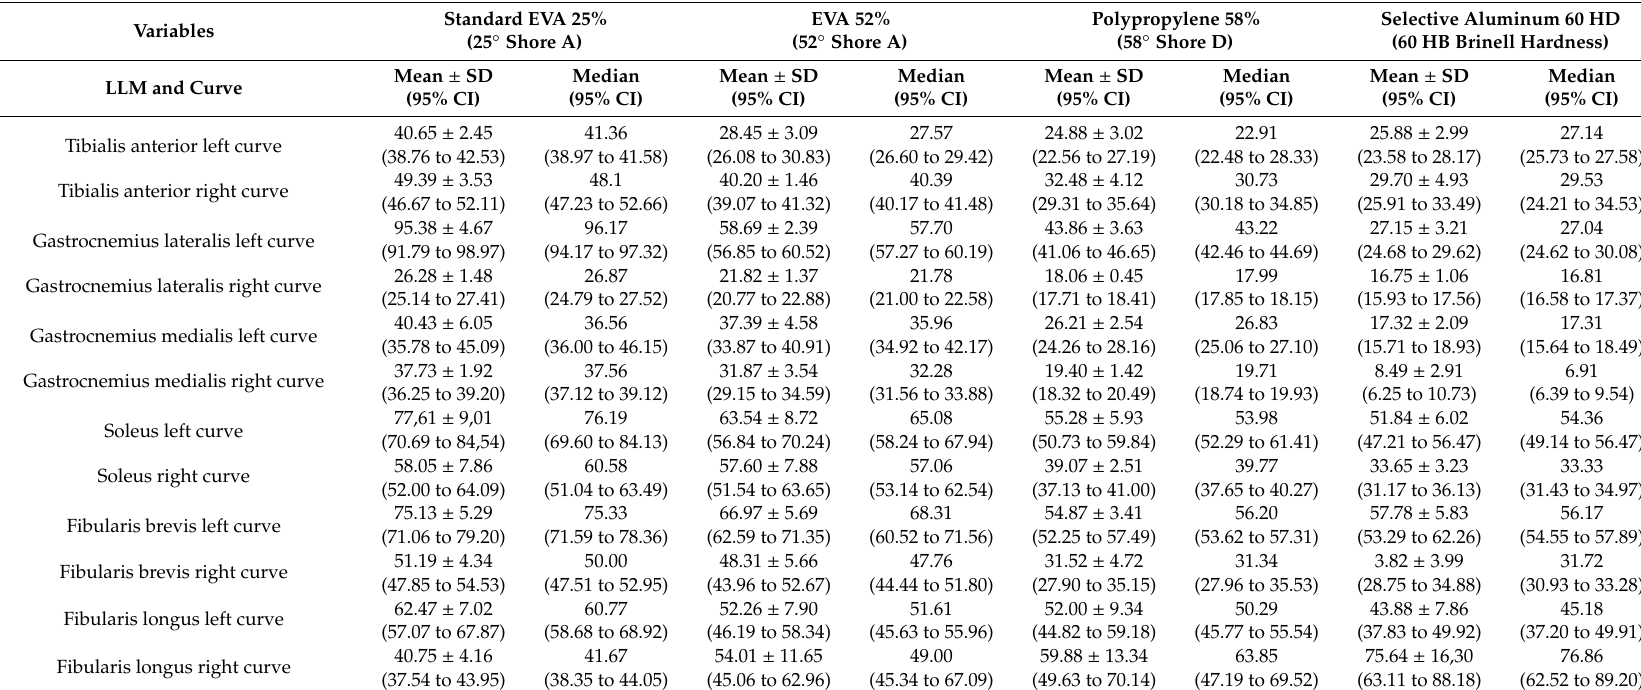
Table 4. Maximum muscular activity of the lower limb muscles (LLM) as measured by EMG for di ff erent customized foot insoles (CFI) for left and right curves in the